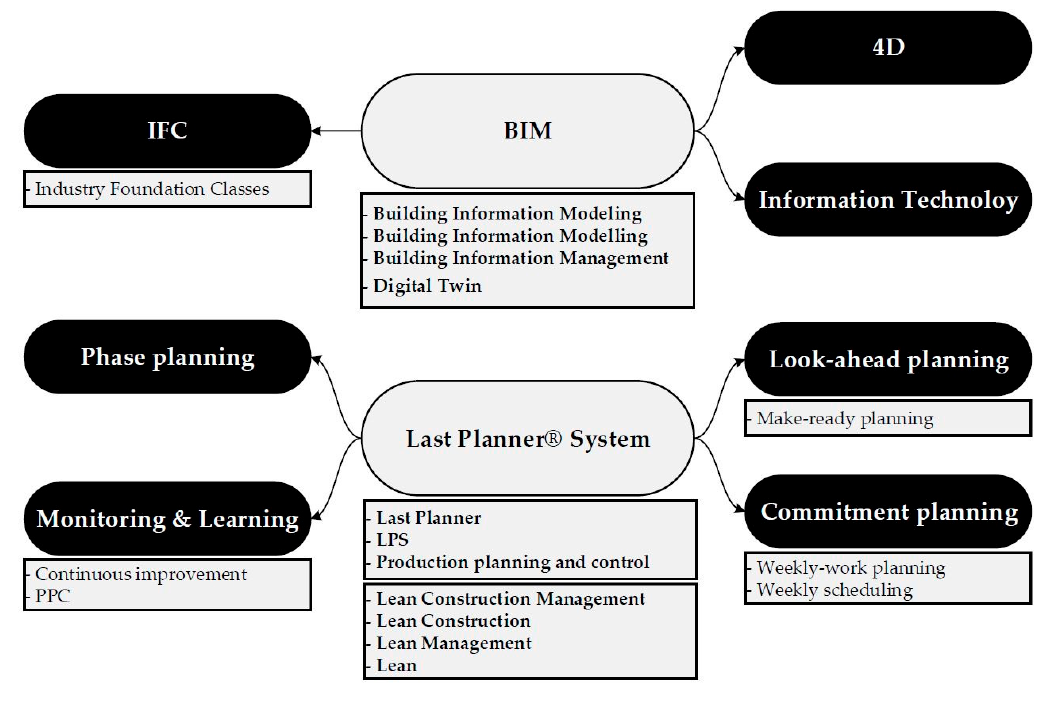
Figure 4. Search terms word tree.